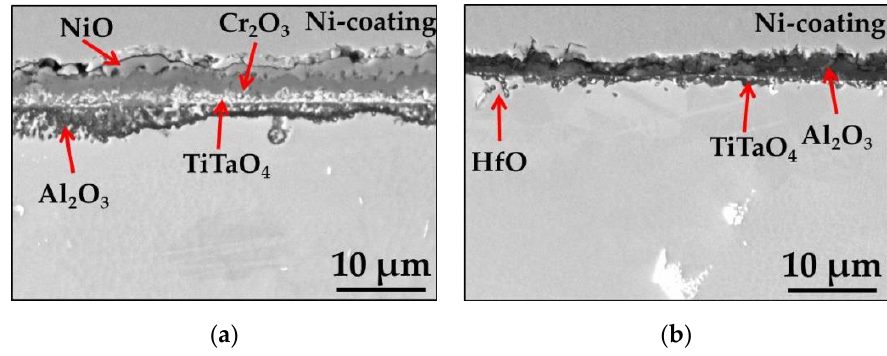
Figure 4. SEM/BSE images performed on cross-sections of Mar M 247 after isothermal air oxidation test at 1000 °C up to 48 h showing oxide scale formed on: ( a ) Polished surface; ( b ) Ground surface.